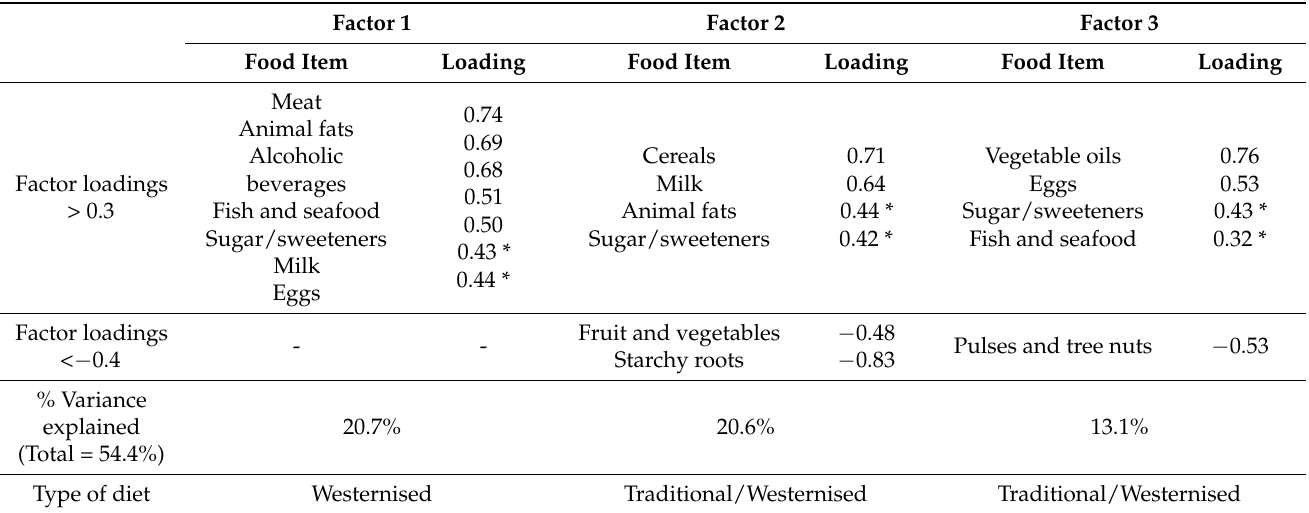
Table 2. Summary of the factor loadings and the constructs after factor analysis on the per capita kcal/day intake of the 12 main food categories from the FAO food balance